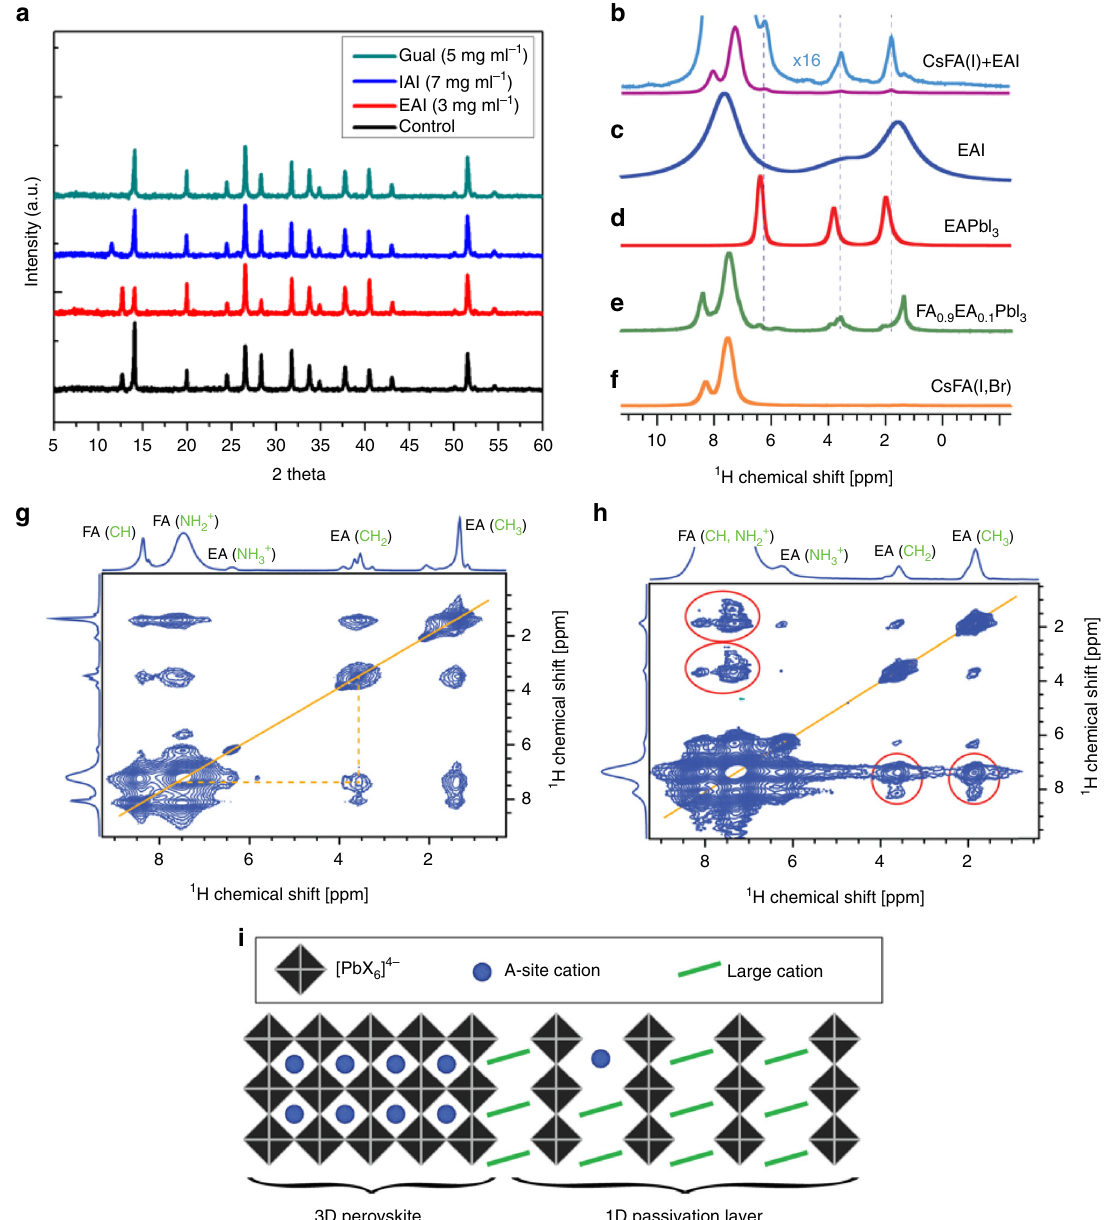
Fig. 2 Structural characterization of the passivated perovskite fi lms: a XRD patterns of the treated fi lms compared to the control. Solid-state 1 H MAS NMR measurements at 21.1 T, 300 K and 20 kHz MAS (unless noted otherwise): b thin fi lm of CsFA(I) treated with 5 mg ml − 1 EAI (at 60 kHz MAS), c neat EAI, d bulk mechanochemical EAPbI 3 , ( e ) bulk mechanochemical FA 0.9 EA 0.1 PbI 3 , f thin fi lm of FA 0.93 Cs 0.07 Pb(I 0.92 Br 0.08 ) 3 (CsFA(I,Br)), g 1 H – 1 H spin diffusion (20 kHz MAS) experiment evidencing atomic-level proximity between FA and EA in the mixed FA/EA phase; one of the EA/FA cross-peaks has been indicated with dashed lines. h 1 H – 1 H spin diffusion experiment (60 kHz MAS) evidencing atomic-level proximity between FA and EA in